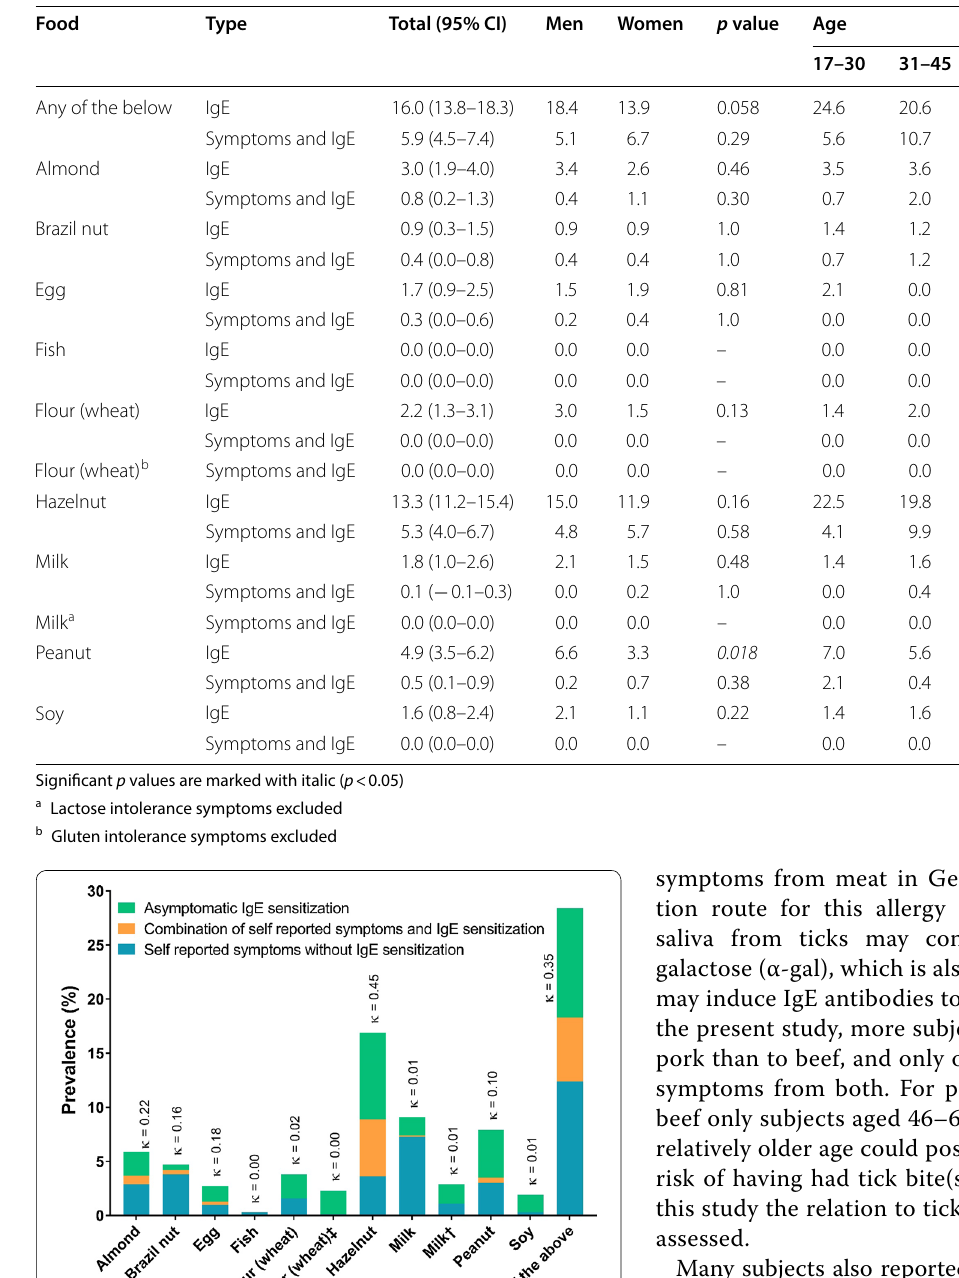
Table 4 Prevalence of positive IgE tests for the most common foods, in combination with self-reported symptoms for the different foods, according to sex and age distribution (%)